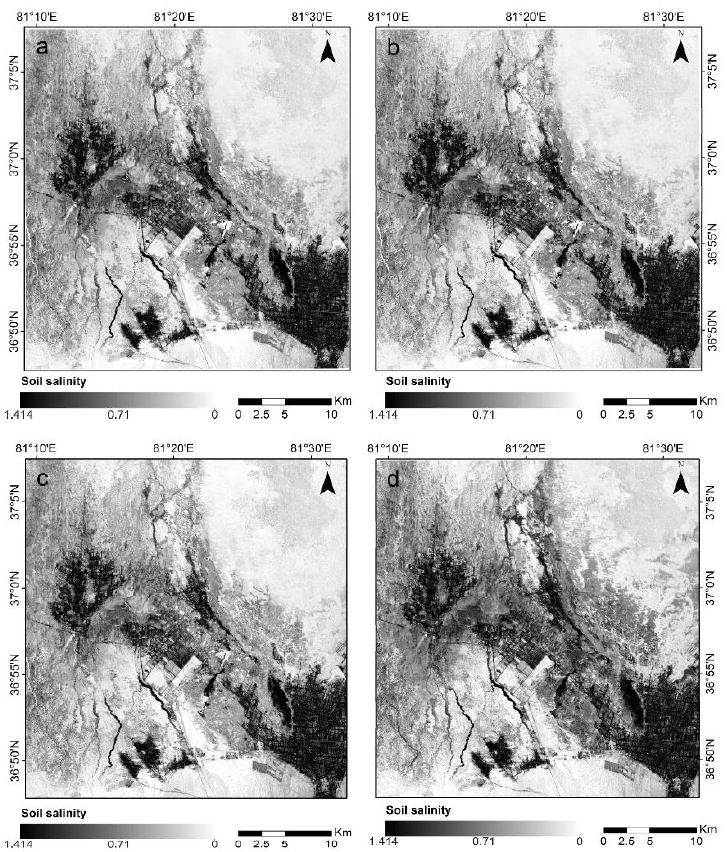
Figure 12. Soil salinity inversion results of the study area: ( a ) ORSDI1; ( b ) ORSDI2; ( c ) ORSDI3; ( d ) ORSDI4.